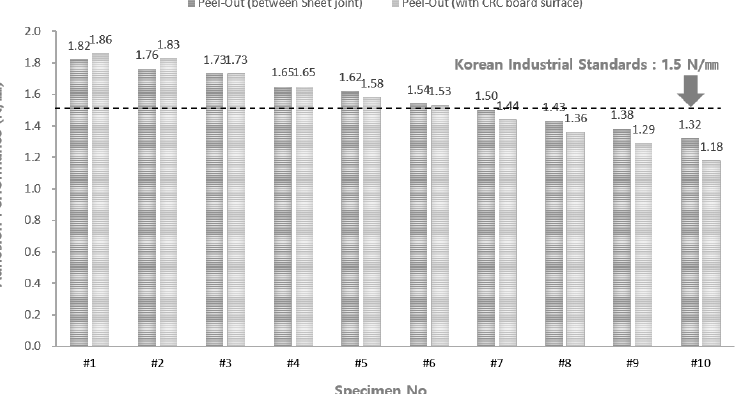
Figure 1. Adhesive strength test (peel-out) result according to reclaimed butyl rubber content.